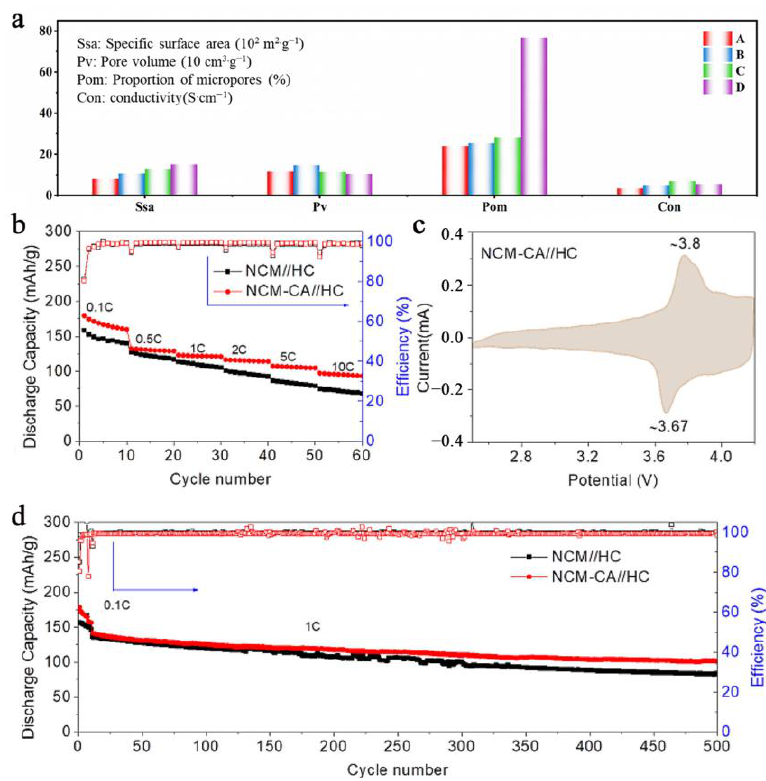
Figure 10. ( a ) Physical properties of several porous carbon materials; (NCM622 + CA)//pre-lithiated HC LIBCs: ( b ) Rate performance; ( c ) Cyclic voltammetry curves; ( d ) Cycle performance [62].